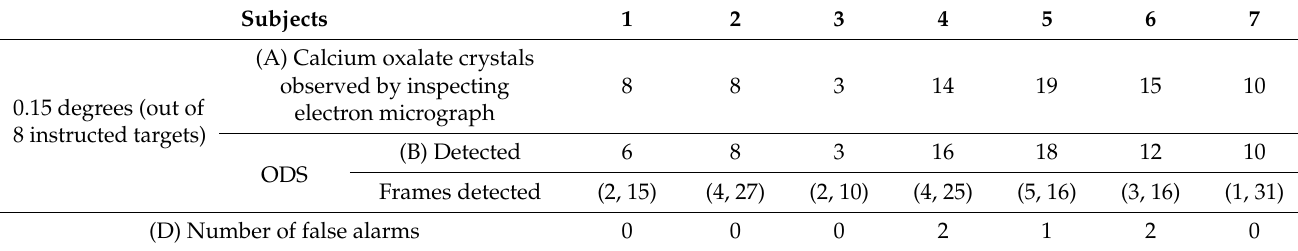
Table 6. Confusion matrix and frame location of detction of calcium oxalate